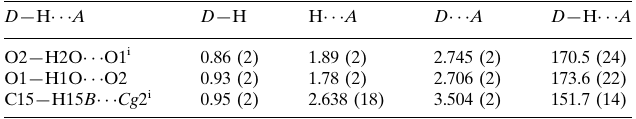
Hydrogen-bond geometry (A˚ , (cid:1) ). Cg 2 is the centroid of the C9–C14